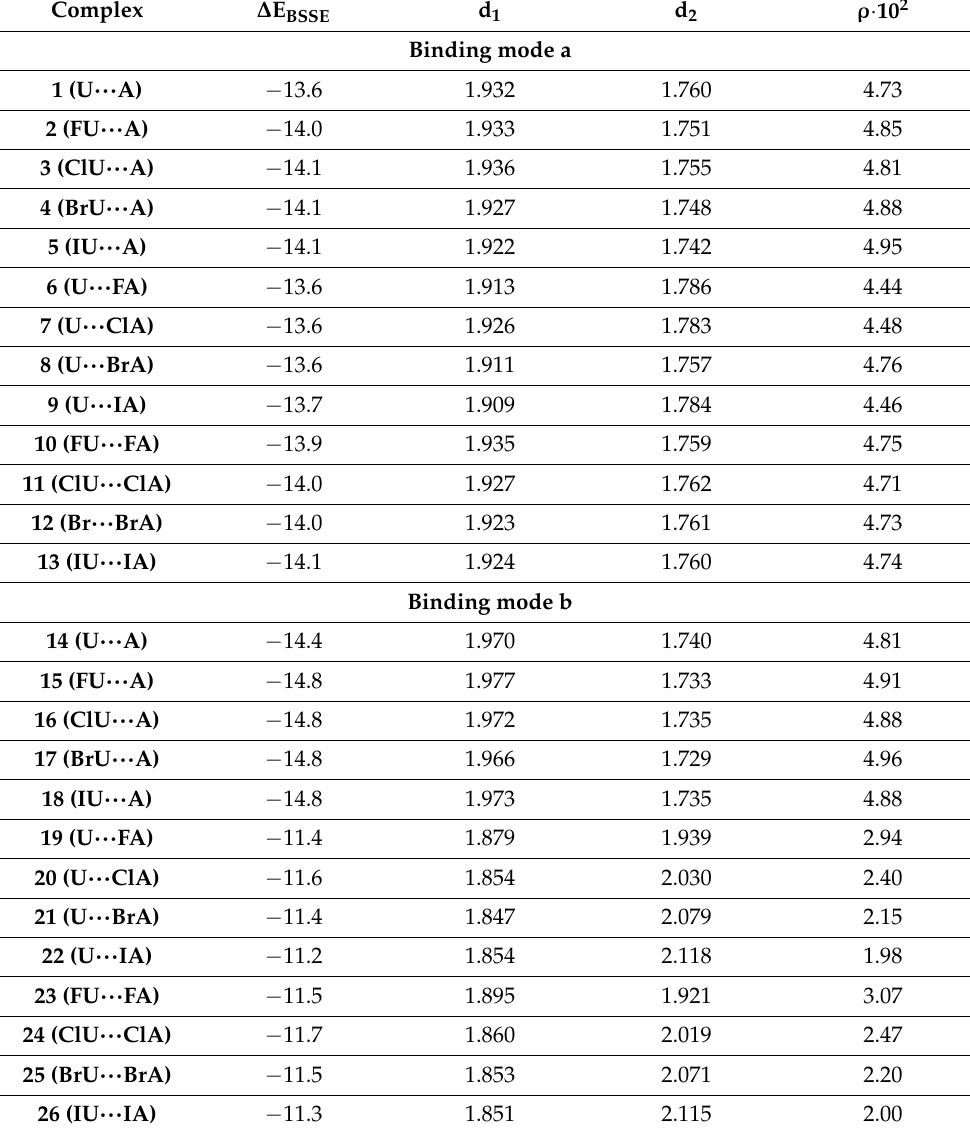
Table 3. BSSE corrected interaction energies ( ∆ E BSSE , in kcal/mol), equilibrium distances (d 1 , d 2 and d 3 in Å) and value of the density at the bond critical point corresponding to the strongest interaction ( ρ · 10 2 in a.u.) for the U ··· A complexes 1 to 52